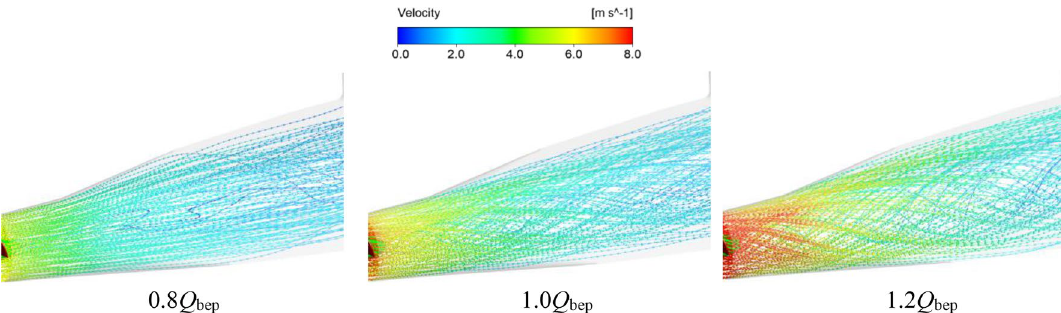
Figure 15. Three-dimensional velocity vector diagrams of the outlet channel under different flow